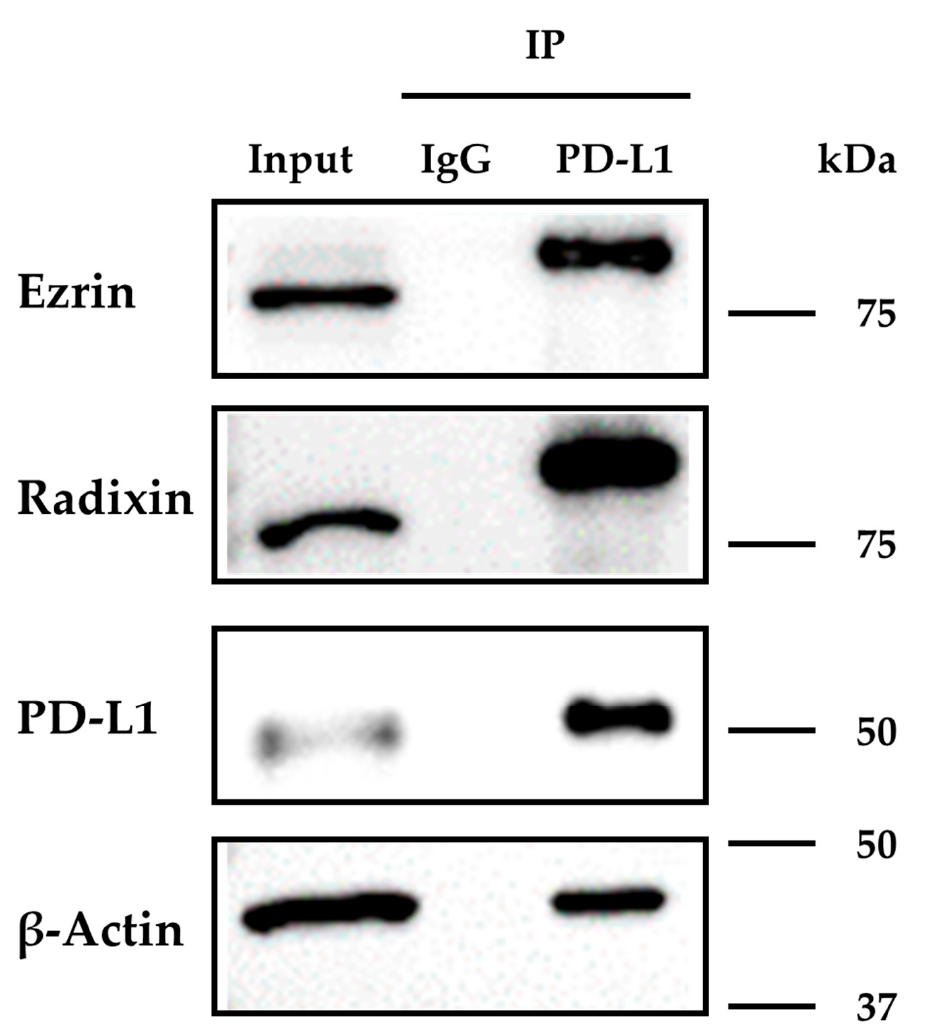
Figure 4. Immunoprecipitation analysis to detect the molecular interactions of programmed death ligand-1 (PD-L1) with ezrin and radixin in KP-2 cells. The whole-cell lysates of KP-2 cells were immunoprecipitated with an anti-PD-L1 antibody or its isotype control antibody. Images of repre- sentative western blots for ezrin, radixin, β -Actin, and PD-L1 in the whole-cell lysates (input) and the immune precipitates (IP) pulled down with a control IgG or an anti-PD-L1 antibody. Molecular weights are indicated in kDa. The images are representative of three independent immunoprecipi- tation experiments using at least three independent replicates of protein extracts.